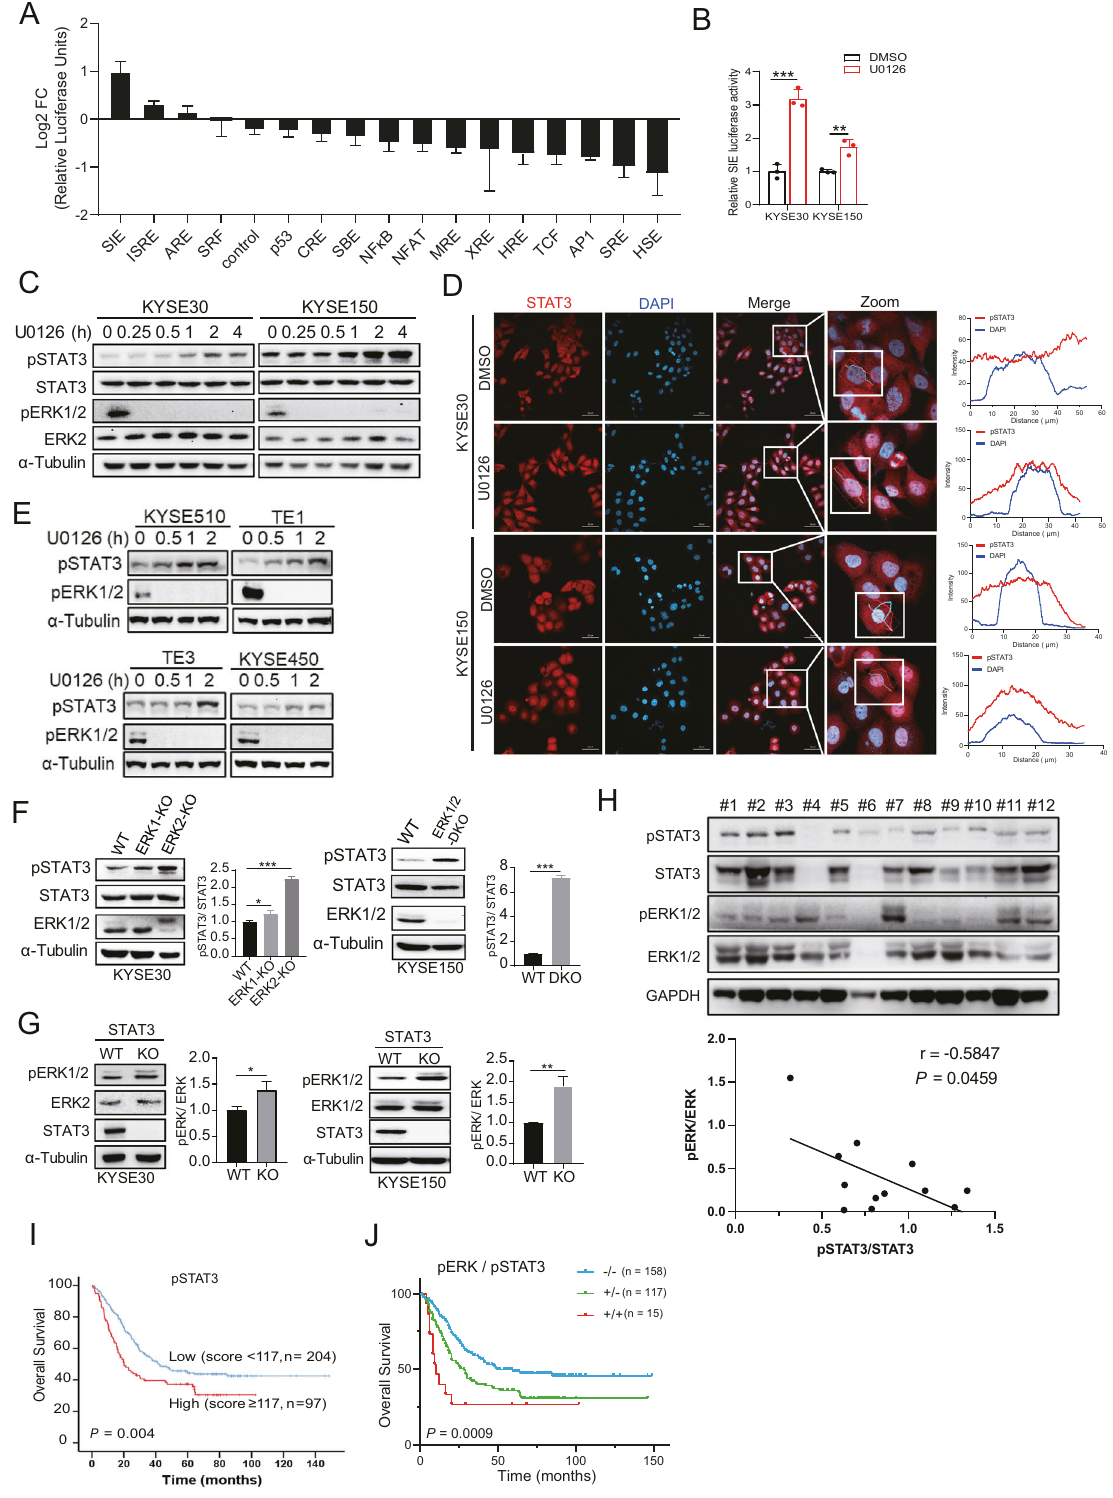
score 103.2) exhibited a more diffuse pERK1/2 staining (Fig. 1B). Consistently, the high pERK1/2 expression level was associated with poor prognosis for overall survival in 301 patients with ESCC ( P = 0.035) (Fig. 1C, D). We then evaluated the effect of ERK1/2 inhibition in six ESCC cell lines using U0126 (a MEK1/2 inhibitor). Phosphorylation of ERK1/2 was dramatically reduced